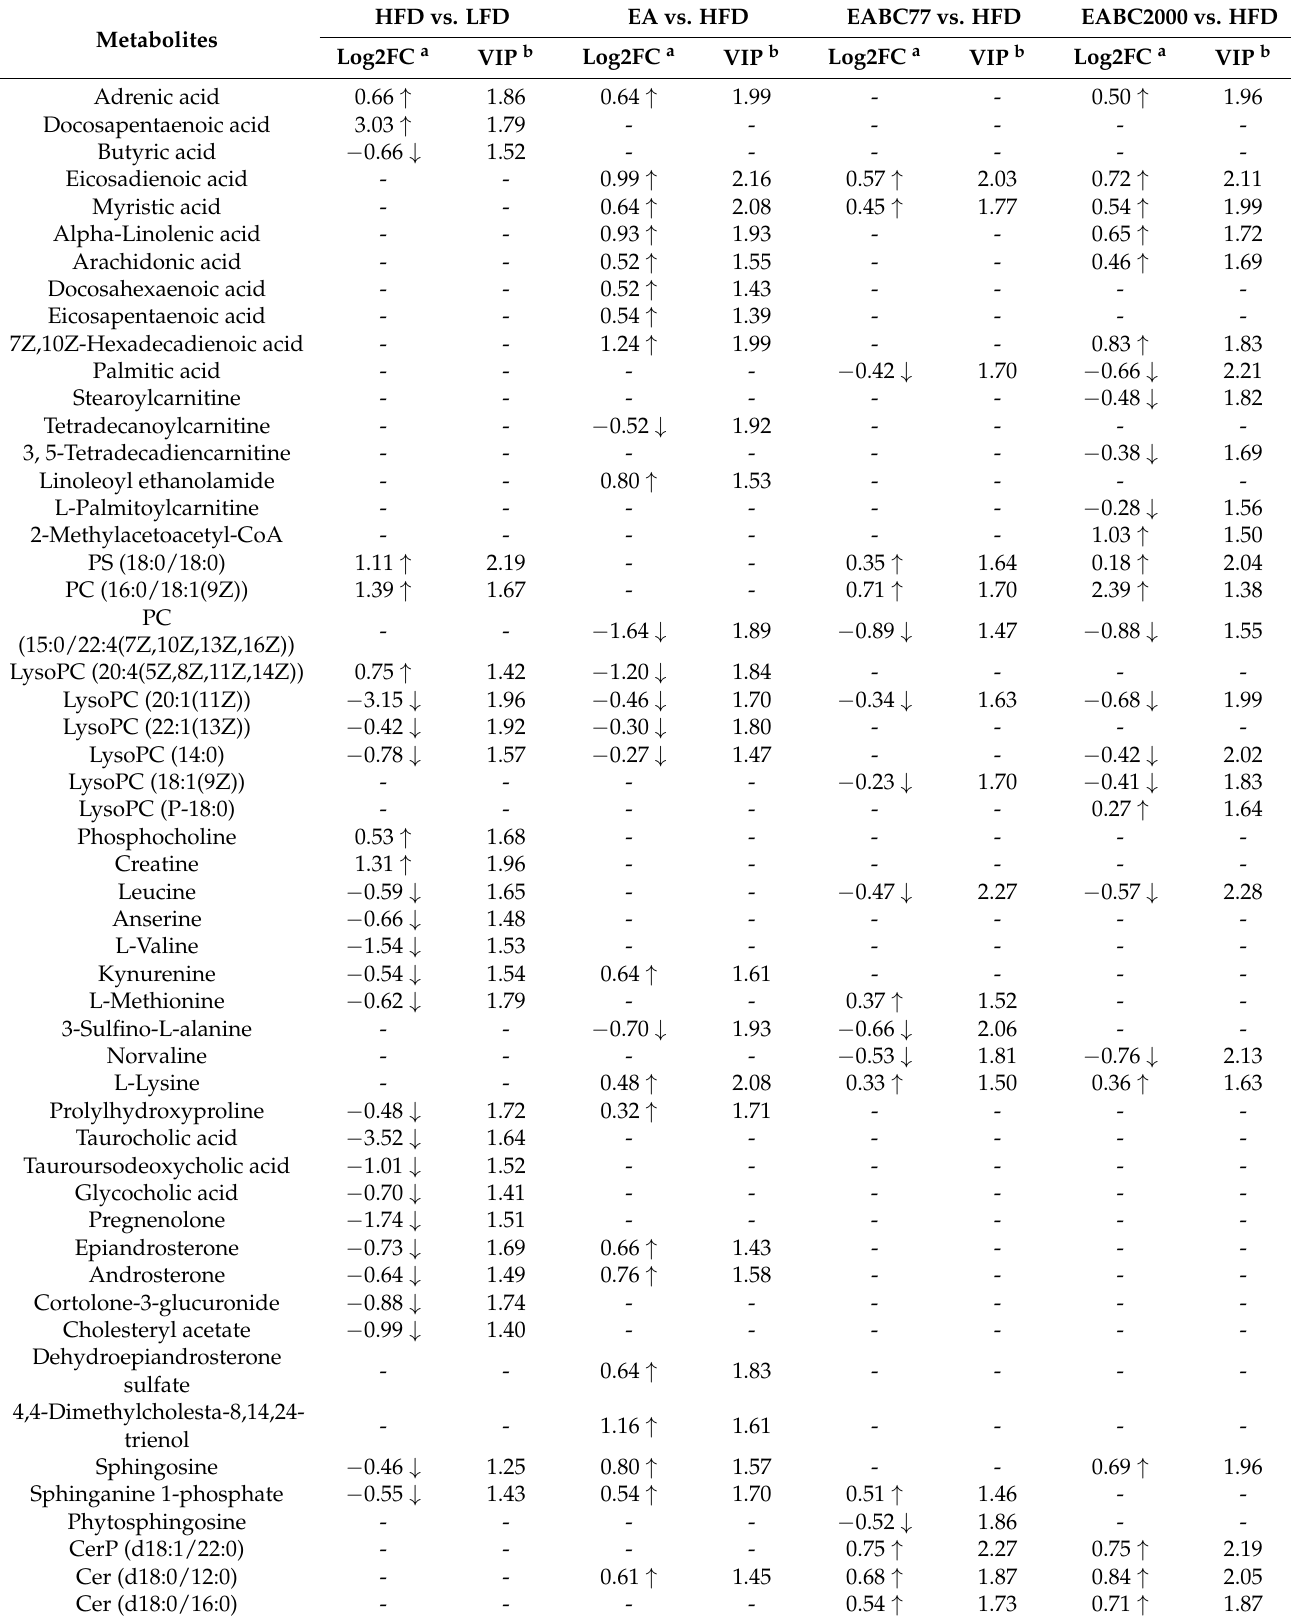
Table 2. Differential metabolites in the mouse